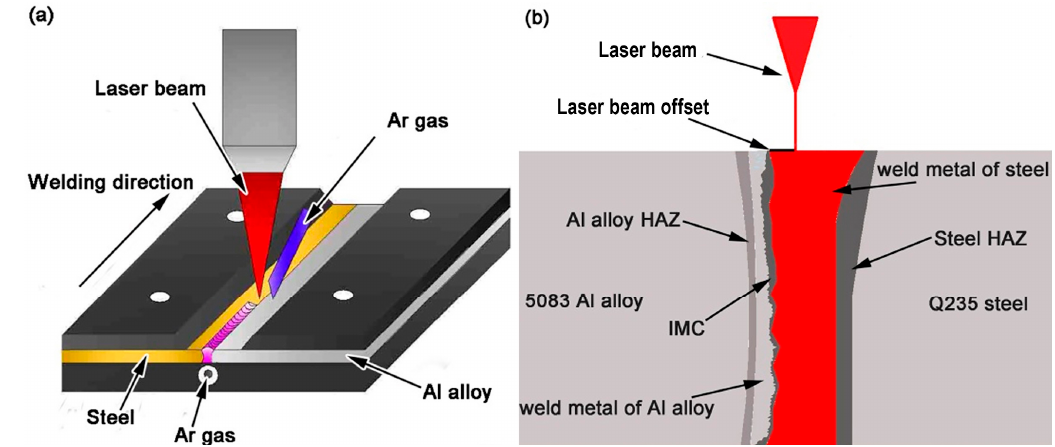
Figure 1. Schematic illustration of laser keyhole welding of Al/steel butt joints: ( a ) welding setup; ( b ) principle of laser keyhole welding.